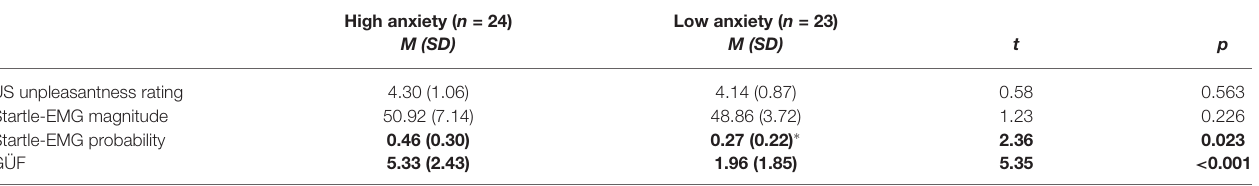
TABLE 2 | Comparison of the high (HA) and low anxiety (LA) groups with regard to responding to the unconditioned stimulus (US) . High anxiety ( n =